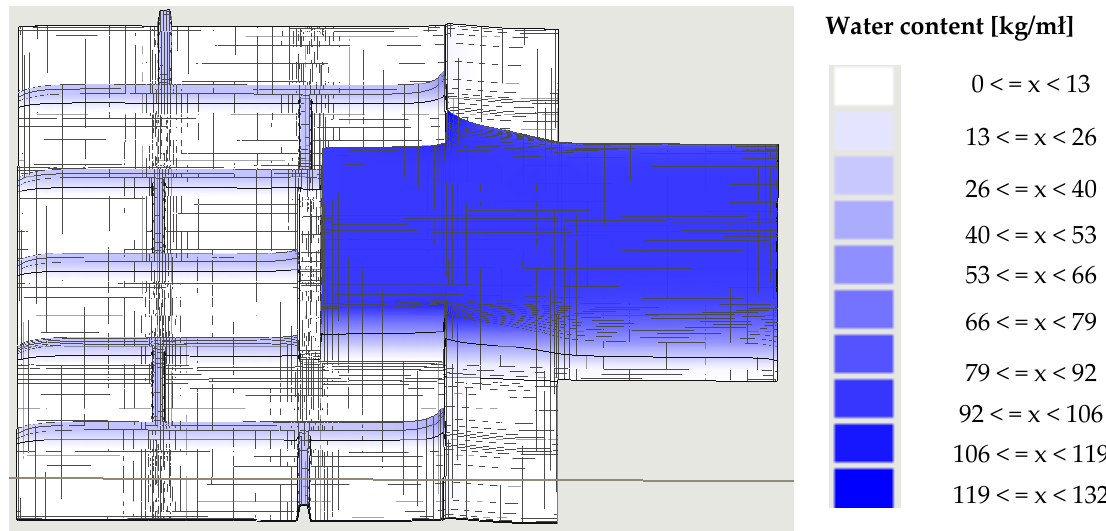
Figure 17. Momentary water content for the junction between the wall and wooden floor beam. Figure 18. Momentary water content for the junction between the wall and wooden floor